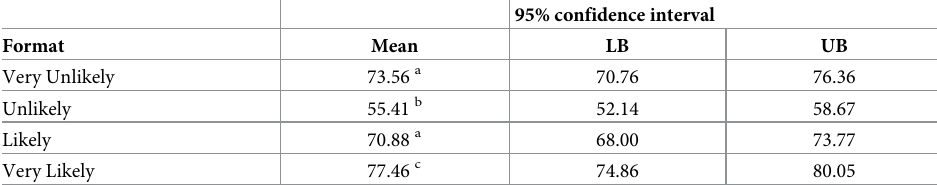
Table 6. Mean percentage of best estimates that agree with the ICD 203 standard by probability term.